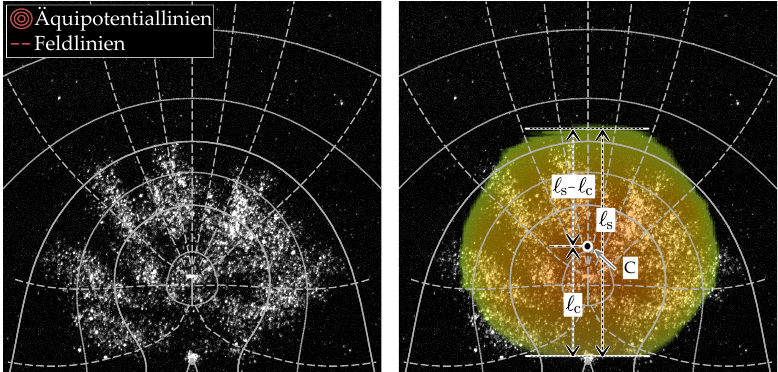
Figure 8. ( Left ): optical shot of streamer discharge with corresponding computation of the electrical field lines (dotted) and the equipotential lines (drawn through)—( Right ): overlay of space charge including the distances of the equivalent representative charge point C . Figure out of